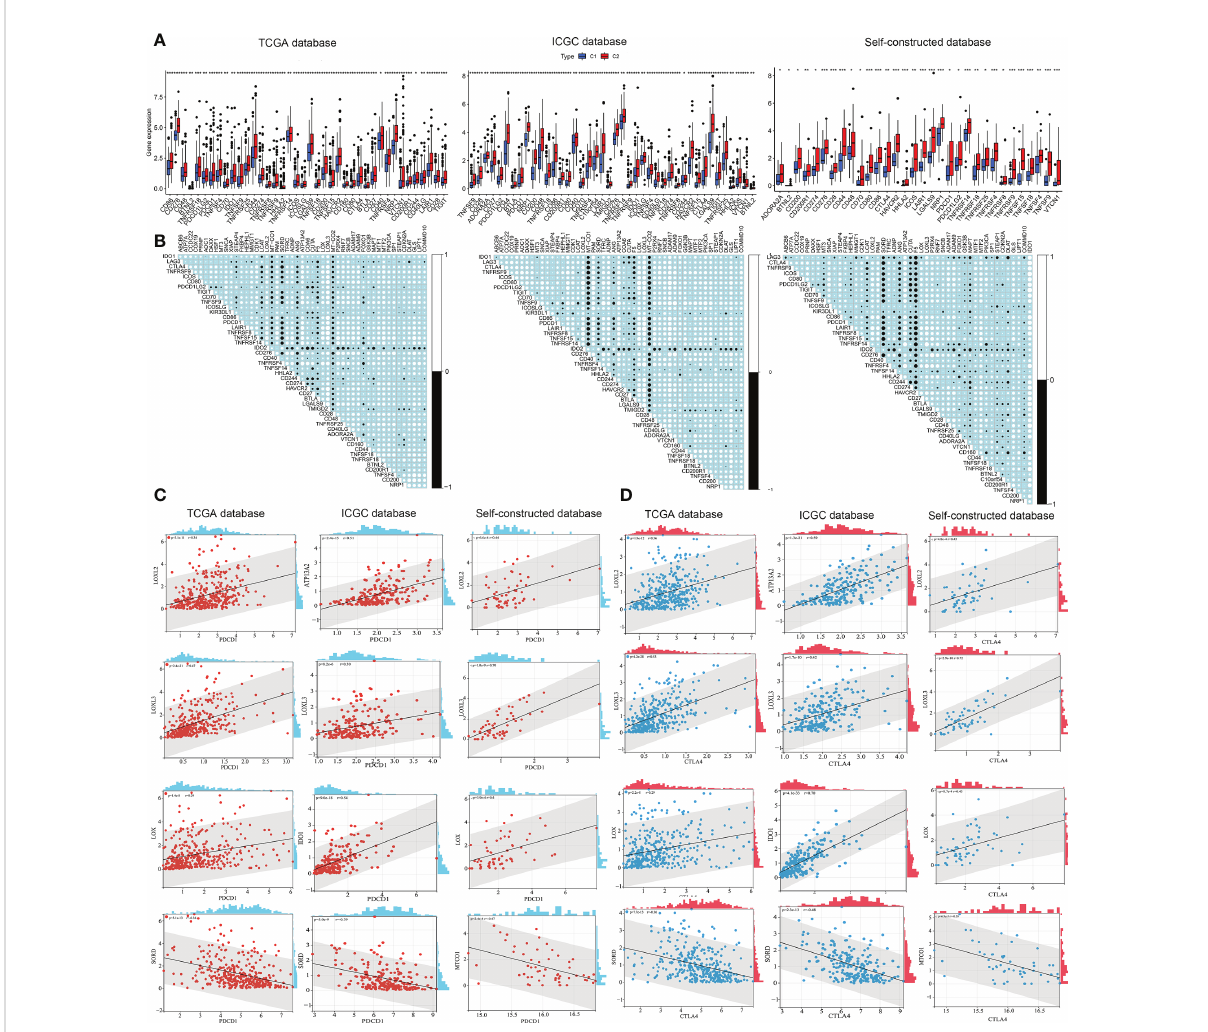
FIGURE 6 Immune checkpoints analysis in both subtypes. (A) Checkpoint analysis among subtypes based on TCGA, ICGC and self-constructed database. (B) Correlation analysis between checkpoints and copper metabolism and cuproptosis-related genes based on TCGA, ICGC and self- constructed database. (C) Signi fi cant correlation genes between PDCD1 and copper metabolism and cuproptosis-related genes based on TCGA, ICGC and self-constructed database. (D) Signi fi cant correlation genes between CTLA4 and copper metabolism and cuproptosis-related genes based on TCGA, ICGC and self-constructed database. *P<0.05, **P<0.01,